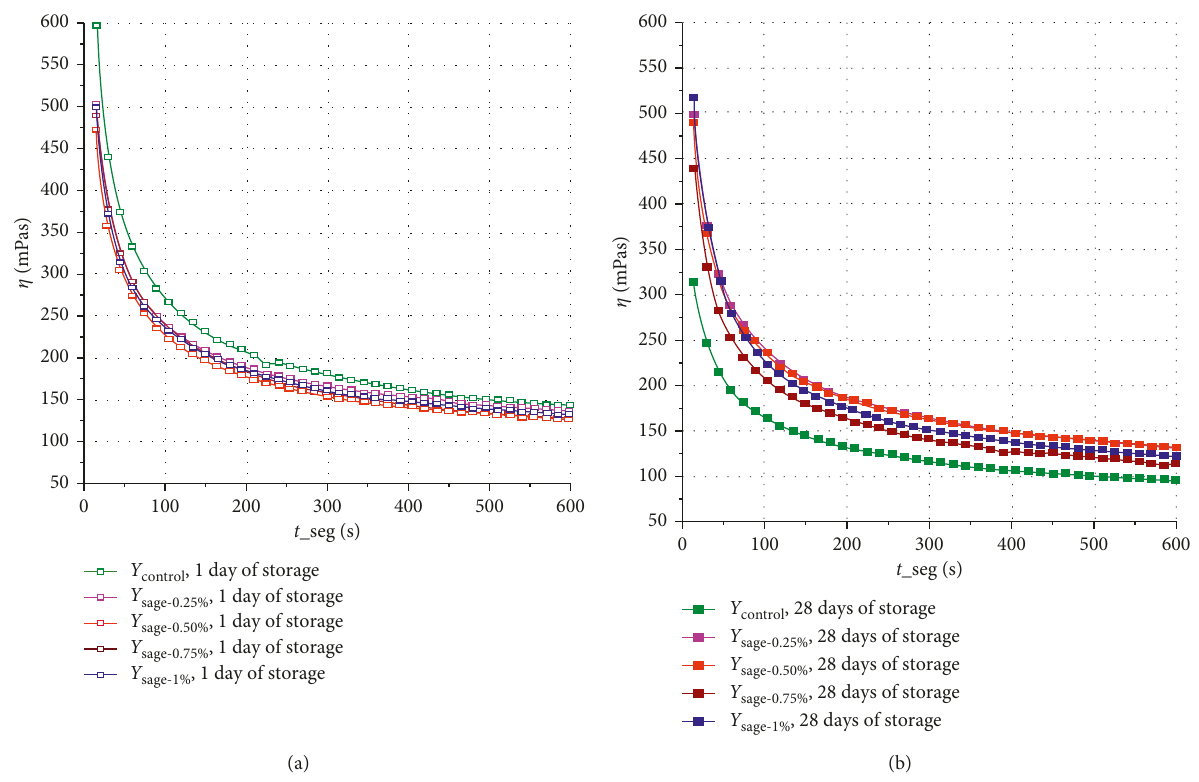
Figure 3: Curve of viscosity versus time of testing thixotropy of yogurt with sage ( Salvia officinalis L.) extract: (a) 1 day of storage; (b) after 28 days of storage.